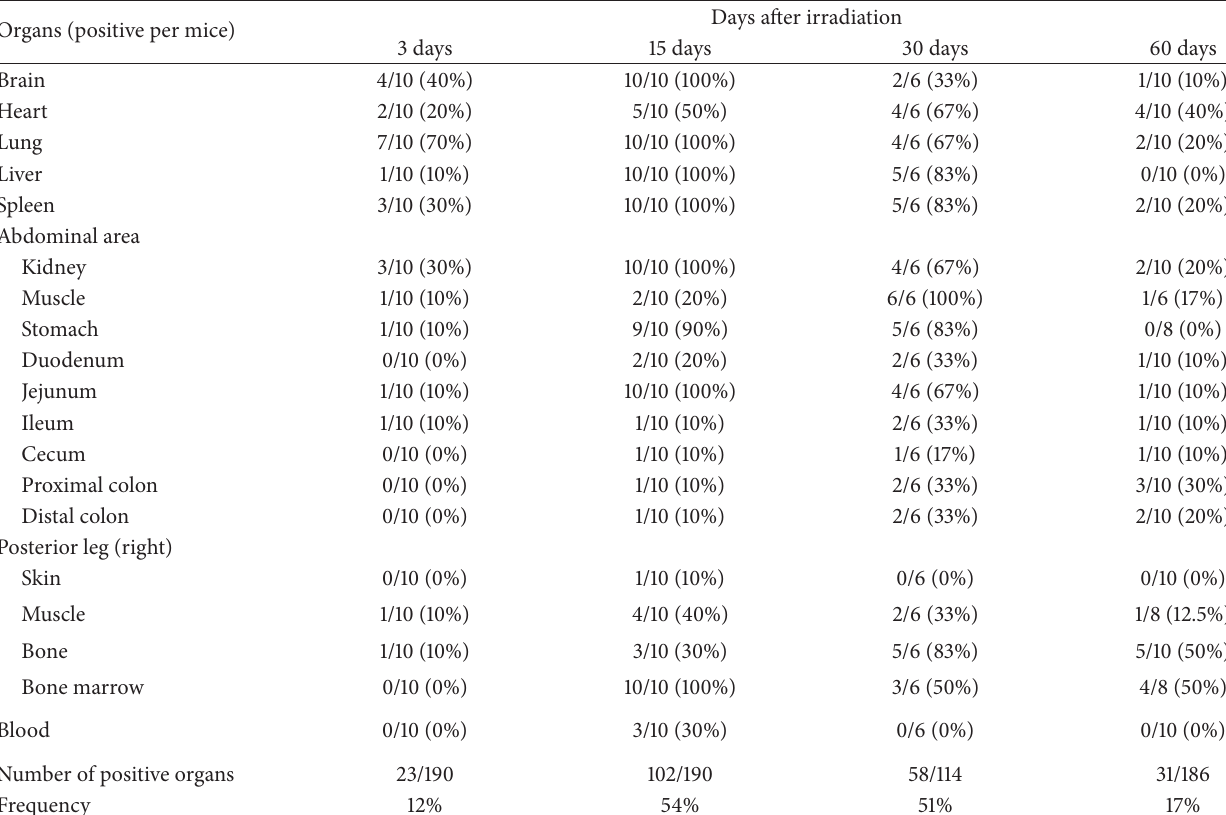
Table 3: Levels of hMSC engraftment at 4 different time points after abdominal irradiation at 8.5 Gray. Organs (positive per